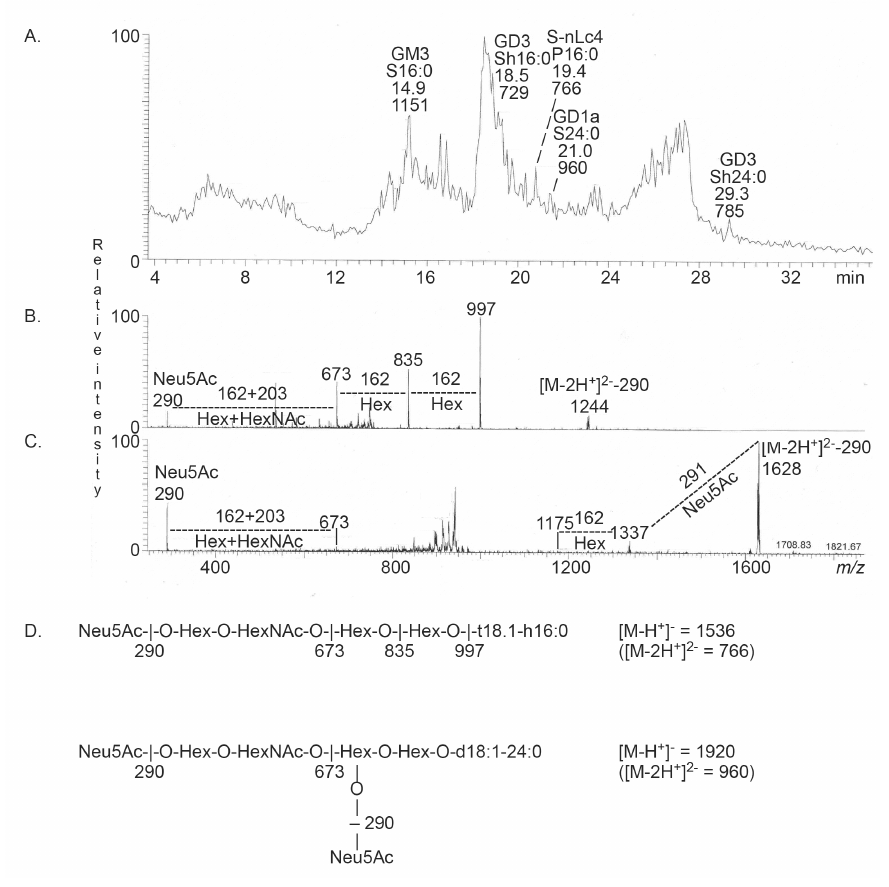
Figure 8. LC-ESI/MS of the acid glycosphingolipid fraction P acid-2 from human parathyroid gland. ( A ) Base peak chromatogram from LC-ESI/MS of the acid glycosphingolipid fraction P acid-2 from human parathyroid gland. ( B ) MS 2 of the ion at m / z 766 (retention time 19.4 min). ( C ) MS 2 of the ion at m / z 960 (retention time 21.0 min). ( D ) Interpretation formulas. GM3, Neu5Ac α 3Gal β 4Glc β 1Cer; GD3, Neu5Ac α 8Neu5Ac α 3Gal β 4Glc β 1Cer; S-nLc4, Neu5Ac α 3Gal β 4GlcNAc β 3Gal β 4Glc β 1Cer; GD1a, Neu5Ac α 3Gal β 3GalNAc β 4(Neu5Ac α 3)Gal β 4Glc β 1Cer. In the shorthand nomenclature for fatty acids and bases, the number before the colon refers to the carbon chain length and the number after the colon gives the total number of double bonds in the molecule. Fatty acids with a 2-hydroxy group are denoted by the prefix h before the abbreviation, e.g., h16:0. For the long chain bases, S designates sphingosine (d18:1; 1,3-dihydroxy-2-aminooctadecene) and P phytosphingosine (t18:0;